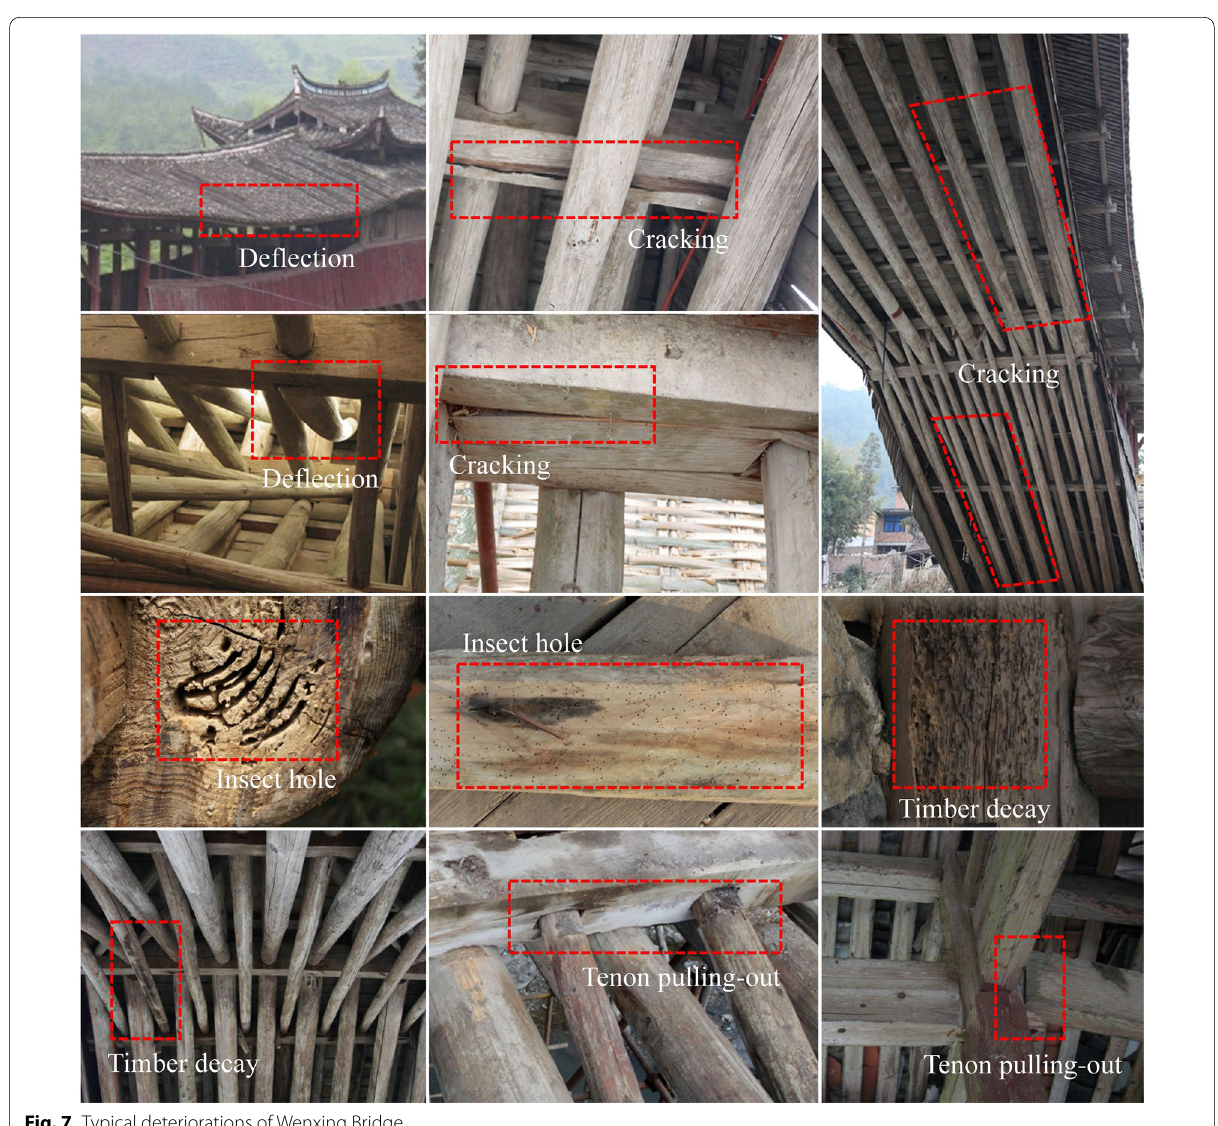
Fig. 7 Typical deteriorations of Wenxing Bridge